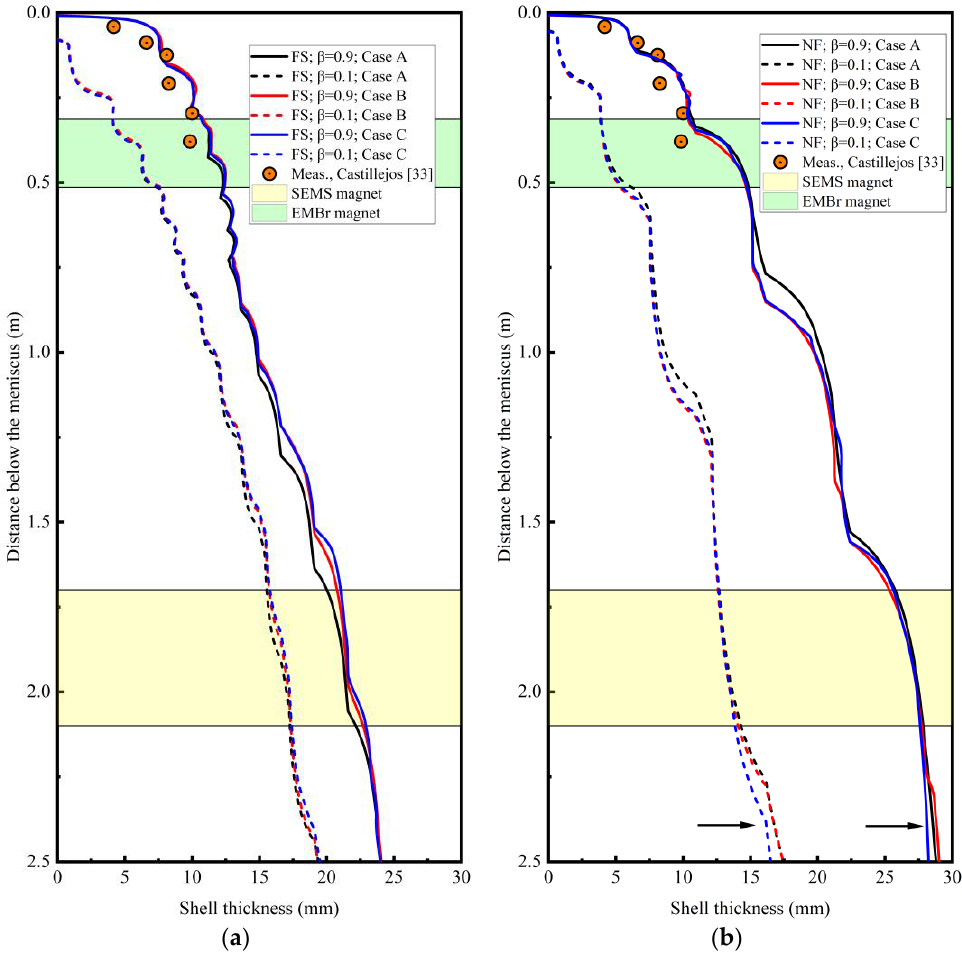
Figure 15. Profiles of the liquid fraction along the casting direction under the three cases: ( a ) in the midsection of the fixed side (FS); ( b ) on the narrow face (NF). The narrow face was in the stirring direction.